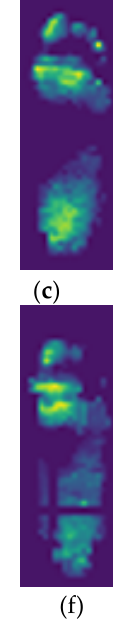
Figure 1. Examples of plantar pressure images after different walking speeds and durations in a representative participant. ( a ) 0.8 m/s for 10 min; ( b ) 1.6 m/s for 10 min; ( c ) 2.4 m/s for 10 min, ( d ) 0.8 m/s for 20 min; ( e ) 1.6 m/s for 20 min; ( f ) 2.4 m/s for 20 min.